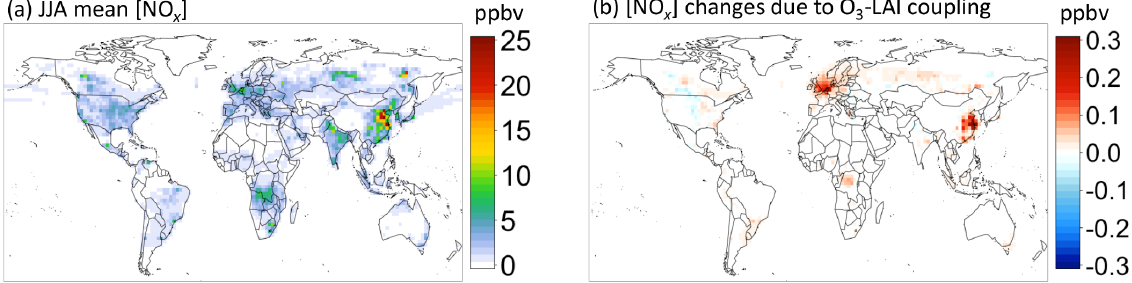
Figure 6. (a) Surface NO x concentration in summer (JJA mean) from the Affected_LAI case, and (b) differences in NO x concentration between the Affected_LAI and Intact_LAI case (i.e., Affected_LAI –